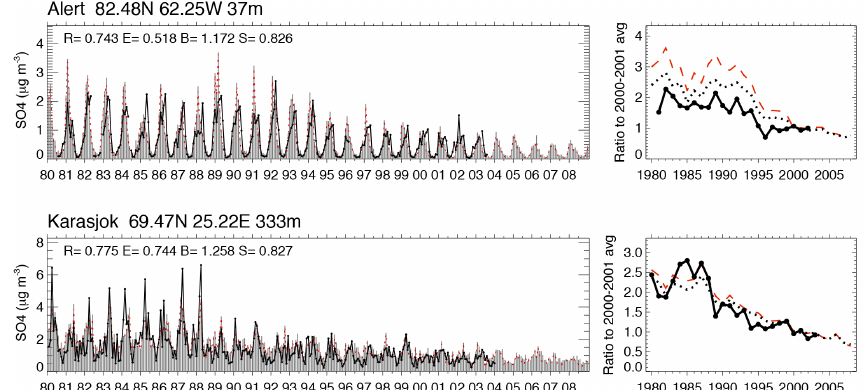
Fig. 8c. Left column: monthly averaged surface sulfate concentration (µgm − 3 ) from 1980 to 2008 at two Arctic sites, Alert, Canada in the western Arctic (top row) and Karasjok, Norway in the eastern Arctic (bottom row). Data provided by P. K. Quinn. Observations are shown in black lines and the model results in grey bars for total amount and dotted red lines for FF + BB amount. Statistical measures ( R , E , B , and S ) are defined as the same as in the Fig. 7 caption. Right column: corresponding ratio of annual mean concentrations to the 2000–2001 average showing the interannual variability/trend over the 20-year period with the observation and models in solid and dotted lines,